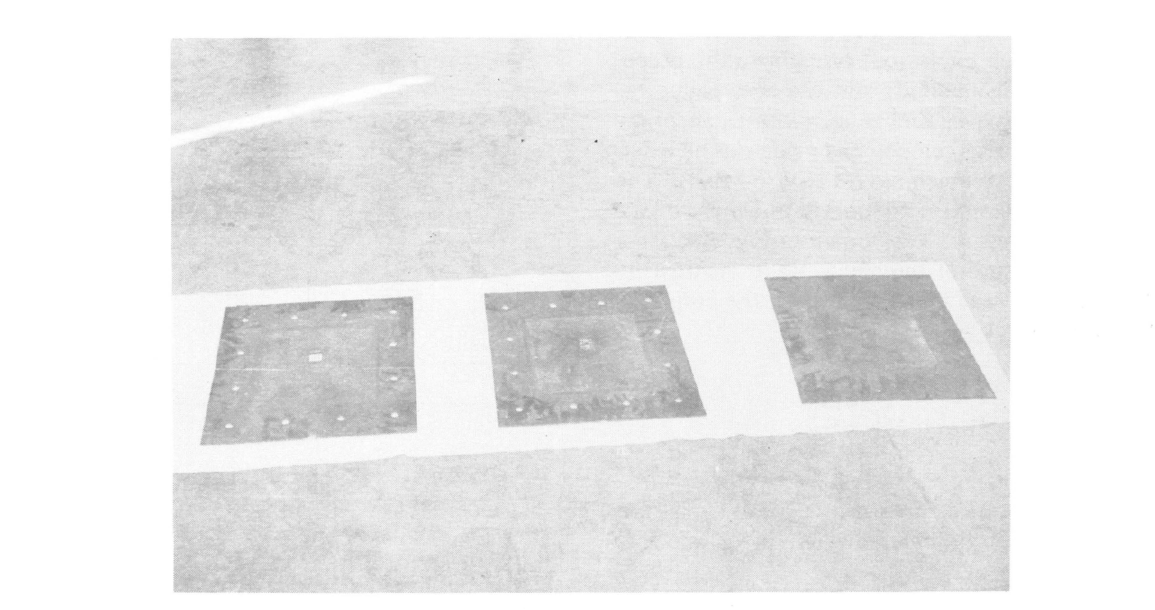
FIGURE 4 Mode-I fracture in single explosive